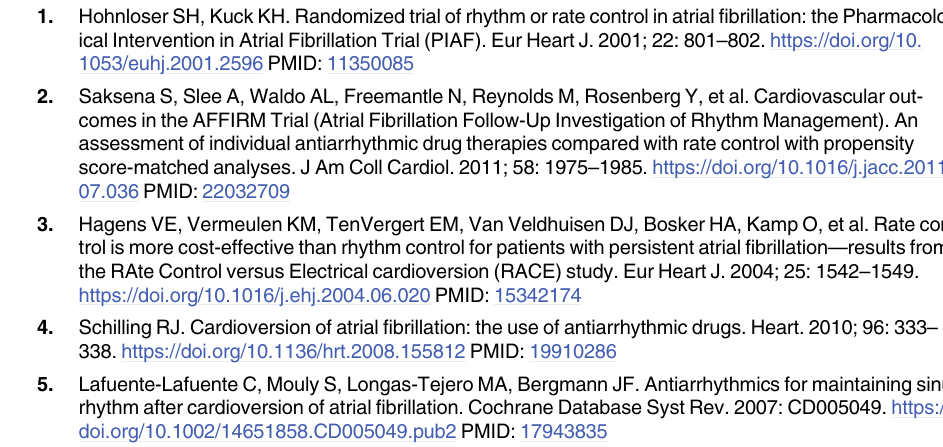
S1 Table. Anticoagulation therapy after electrical cardioversion. S1 Fig. Kaplan-Meier curve for recurrence of atrial fibrillation during the first year after electrical cardioversion according to type of antiarrhythmic drugs (AADs) in patients on de novo AADs. AF indicates atrial fibrillation; AAD, antiarrhythmic drug. P value as calcu- lated by the log-rank test between the 4 AAD groups. ‘No AAD group’ is shown for reference